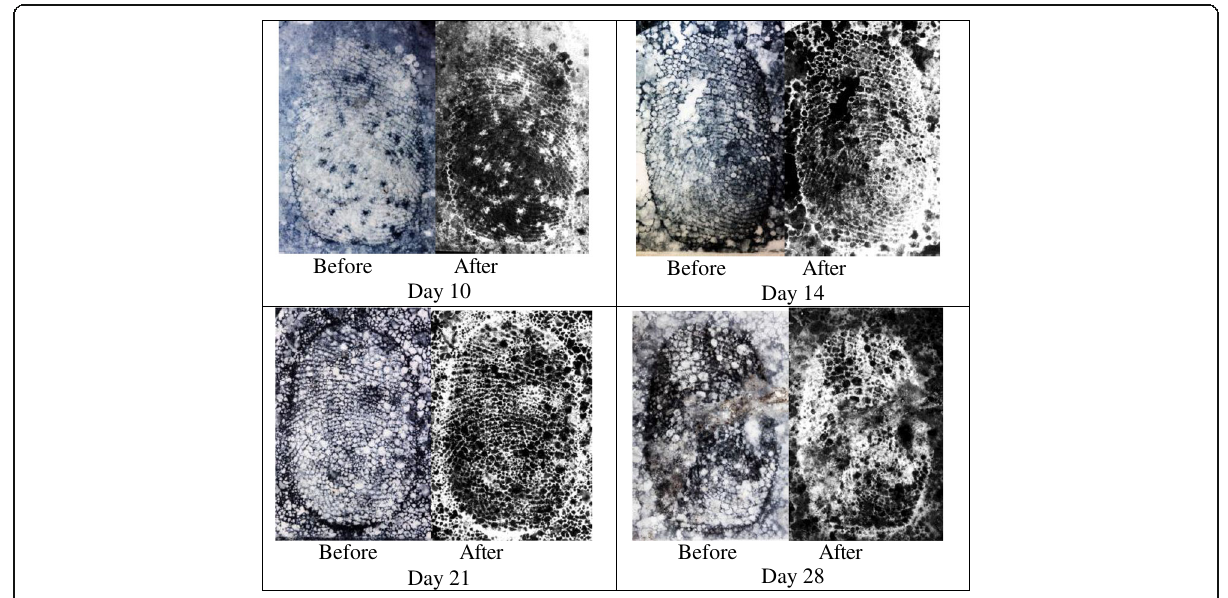
Fig. 19 Pre- and post-digital enhancement of “ second lift ” fingermarks underlying the “ face down ” of the metal